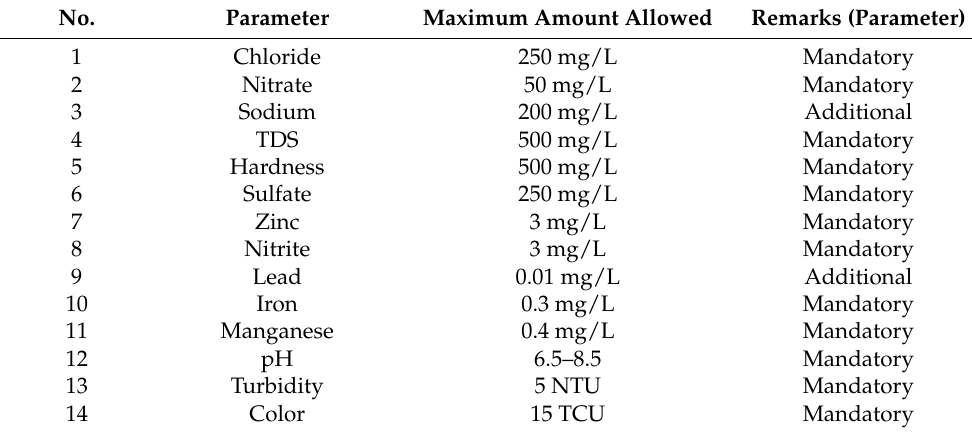
Table A1. Drinking water quality standards 1 related to groundwater.